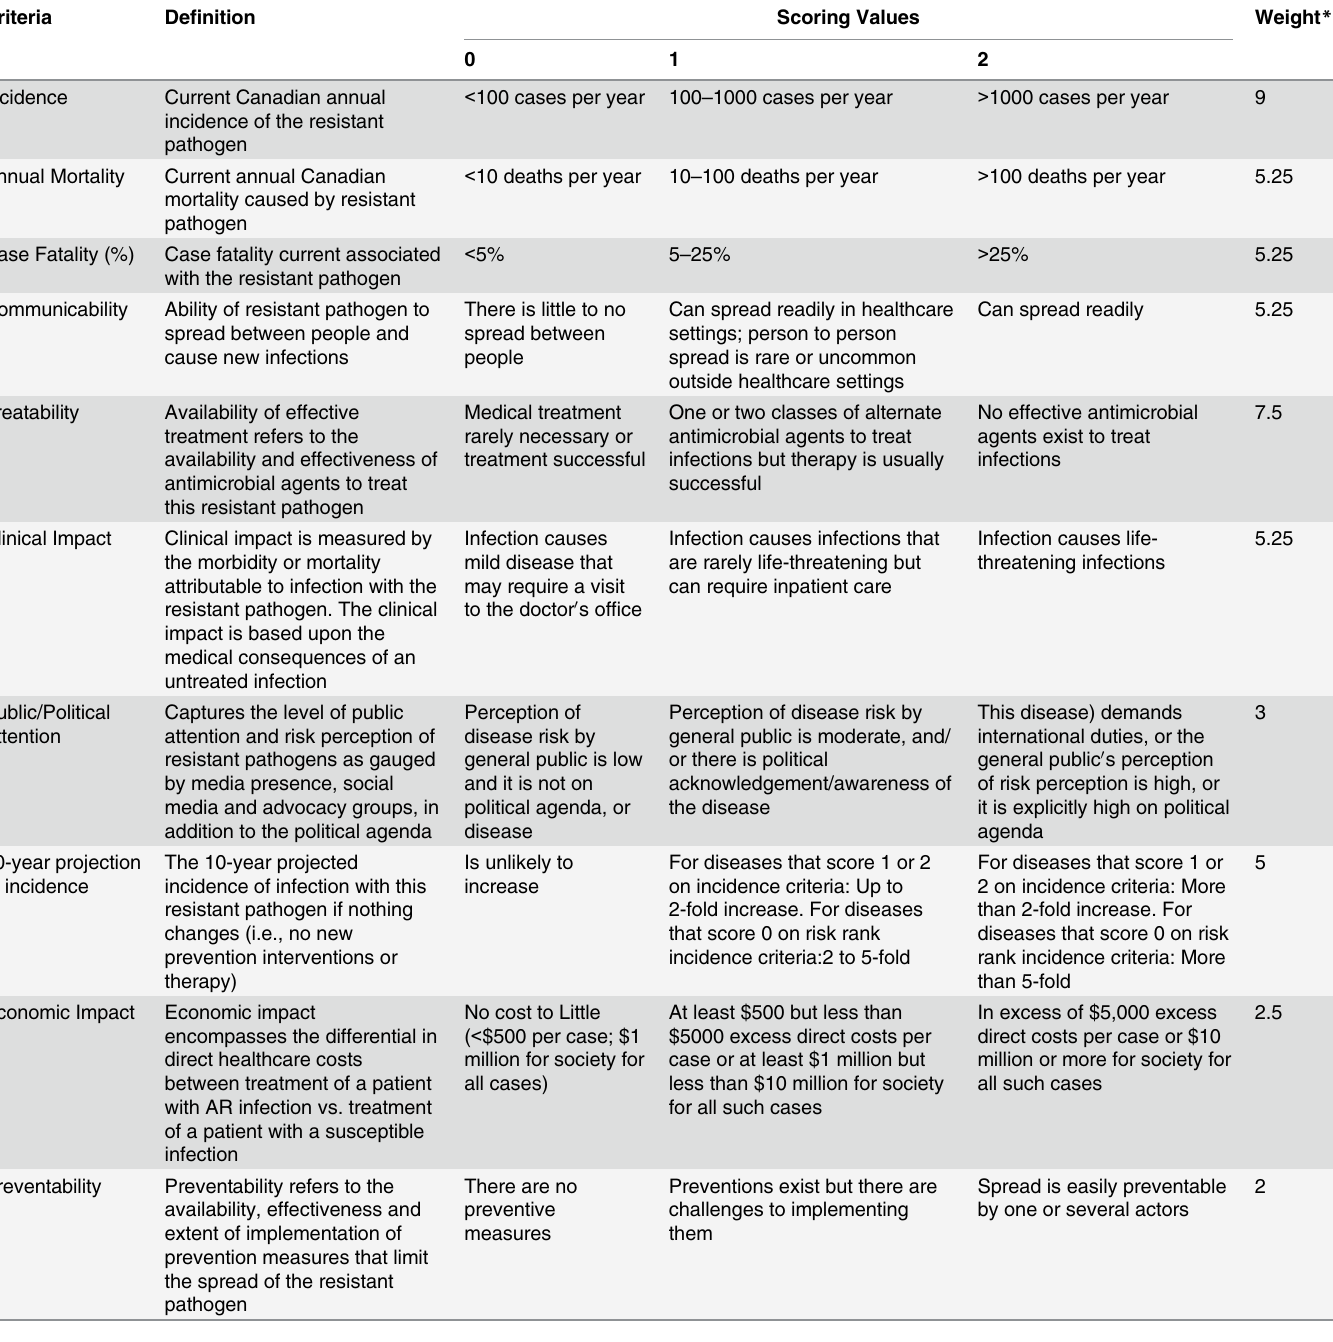
Table 1. Prioritization criteria, scoring definitions, and